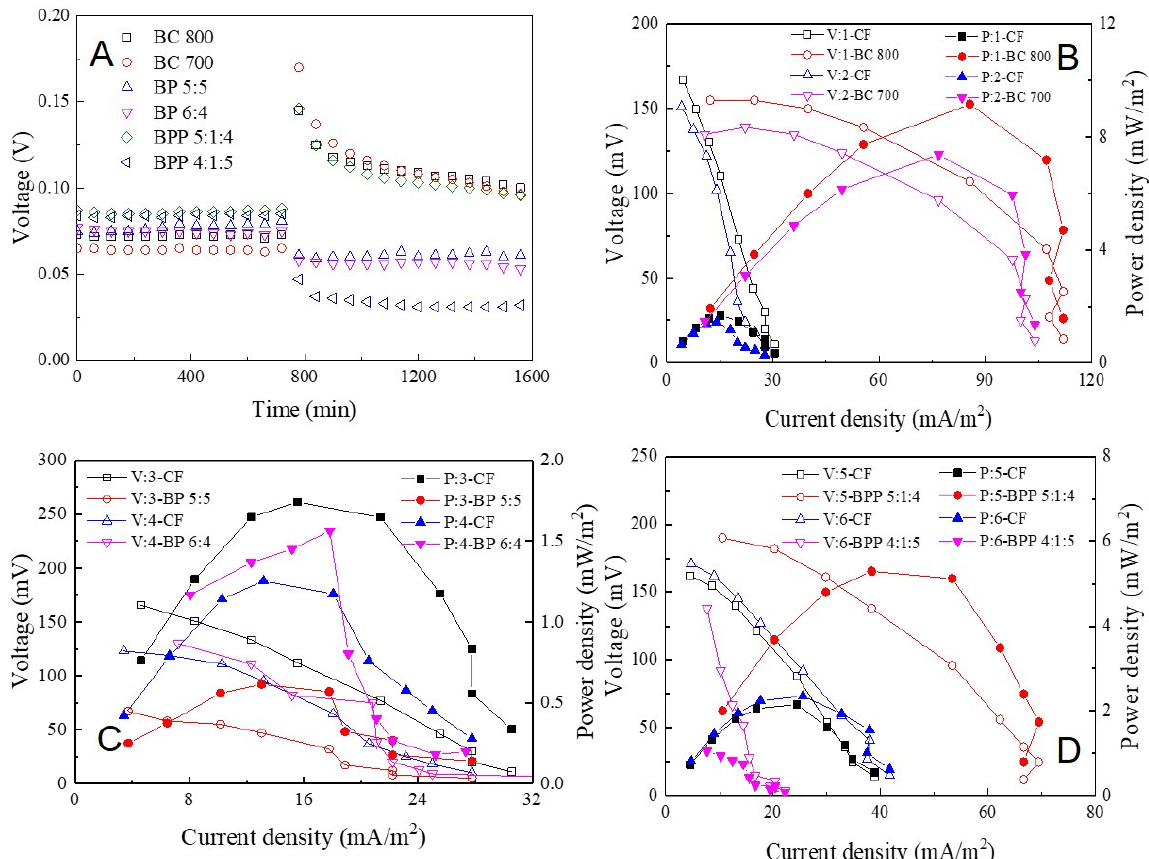
Figure 3. ( A – D ) The performance of the electricity of sediment microbial fuel cell with different biochar-based materials as cathodes.